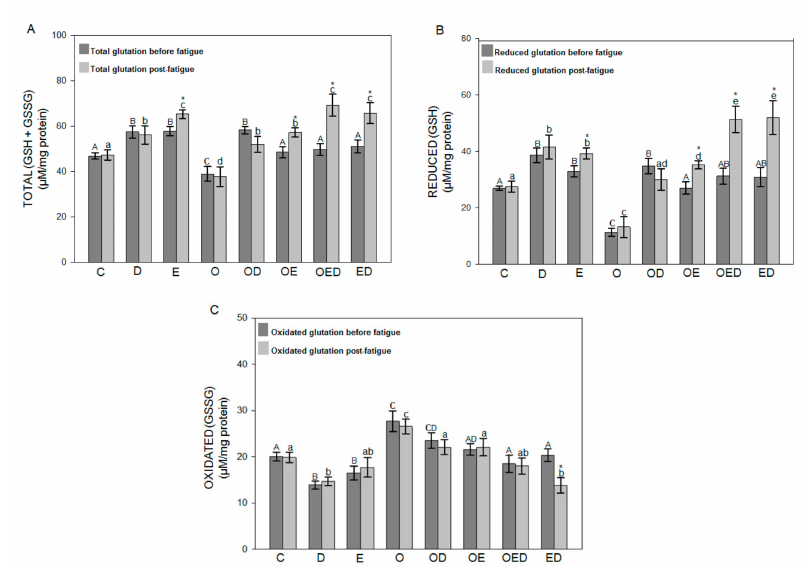
Figure 4. E ff ect of diazoxide and exercise on glutathione redox status in fast skeletal muscle of obese rats. ( A ) EDL muscle with total glutathione, ( B ) EDL muscle with reduced glutathione, and ( C ) EDL muscle with oxidized glutathione, before and after fatigue. C: control; D: diazoxide; E: exercise; O: obese; OD: obese diazoxide; OE: obese exercise; OED, obese exercise with diazoxide; ED: exercise with diazoxide. Data are represented as the mean ± standard error. Di ff erent letters indicate statistically significant di ff erences between the groups, capital letters compare the di ff erent groups before fatigue, and lowercase letters compare the di ff erent groups after fatigue. * indicates significant di ff erences in the comparison of the same group before and after fatigue ( p < 0.05) two-way ANOVA, Tukey’s post-hoc test, n =